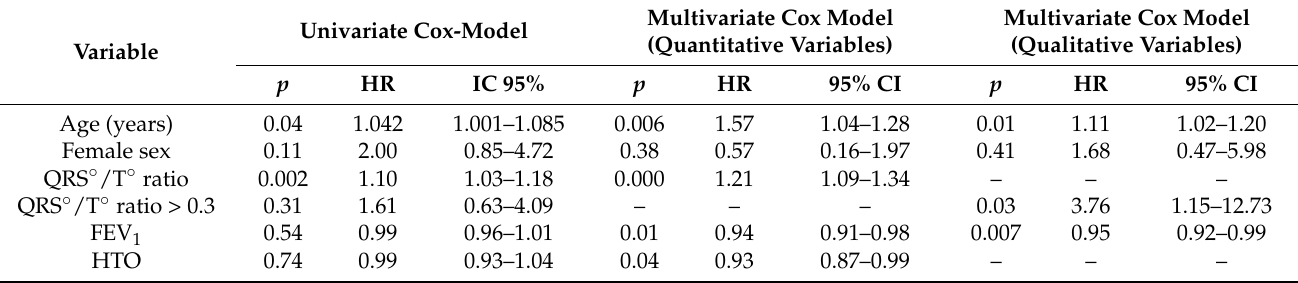
Table 4. Univariate and multivariate Cox models for mortality-associated factors of pulmonary hypertension.